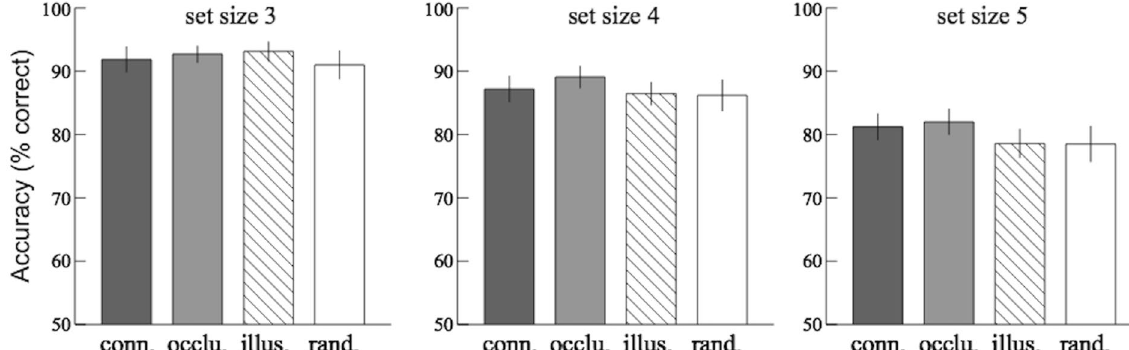
Figure 3. Results of Experiment 1: comparison between the average change detection accuracies for the four configuration conditions – connectedness (conn.), occlusion (occlu.), illusion (illus.), and random orientation (rand.). Error bars indicated standard errors of the